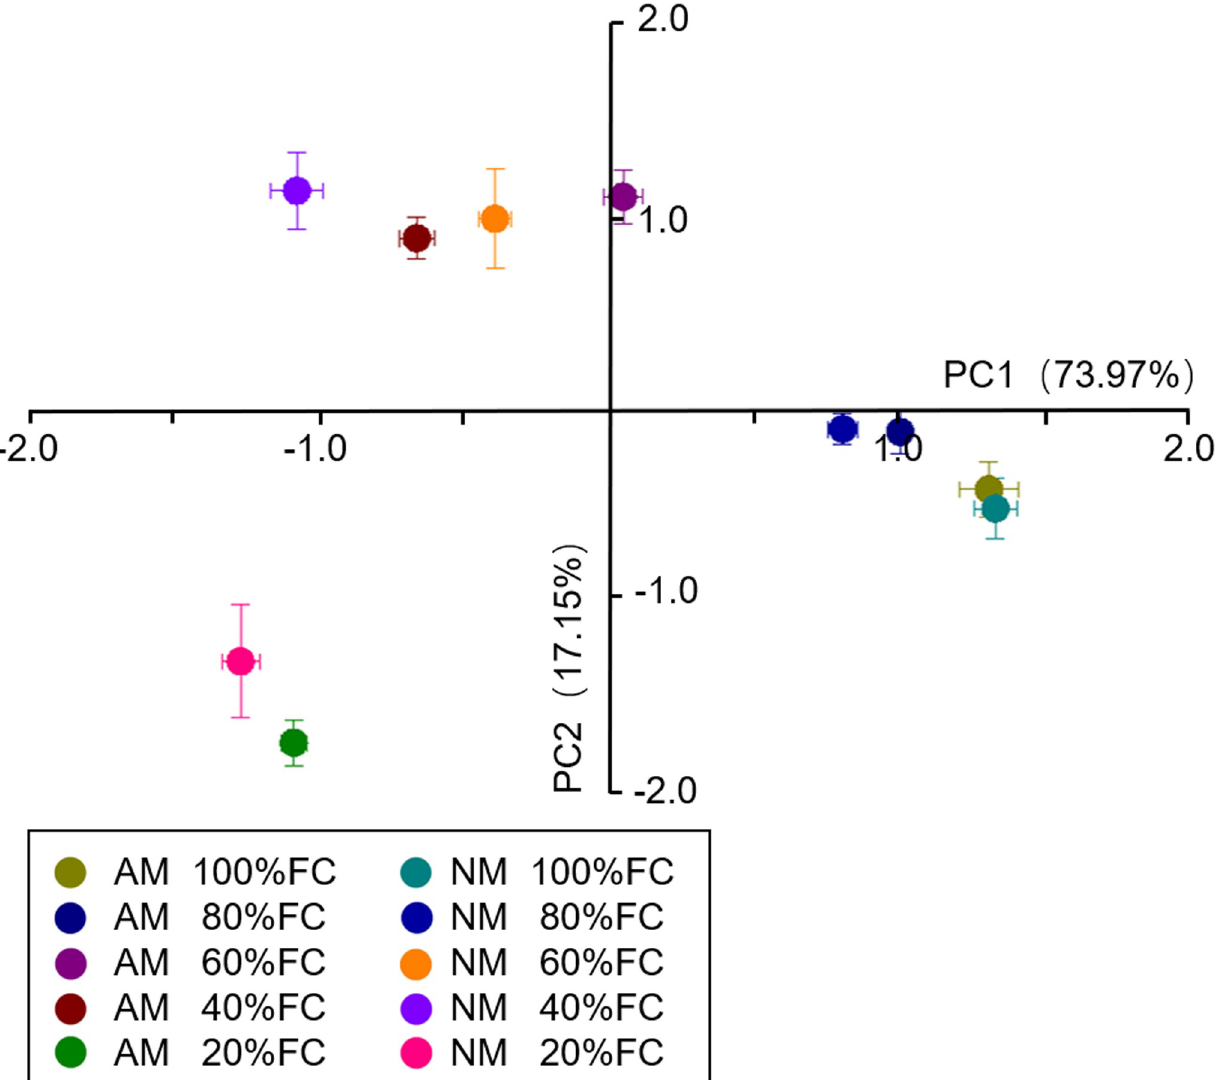
Fig 8. PCA results. AM inoculated treatment; NM: Uninoculated treatment.